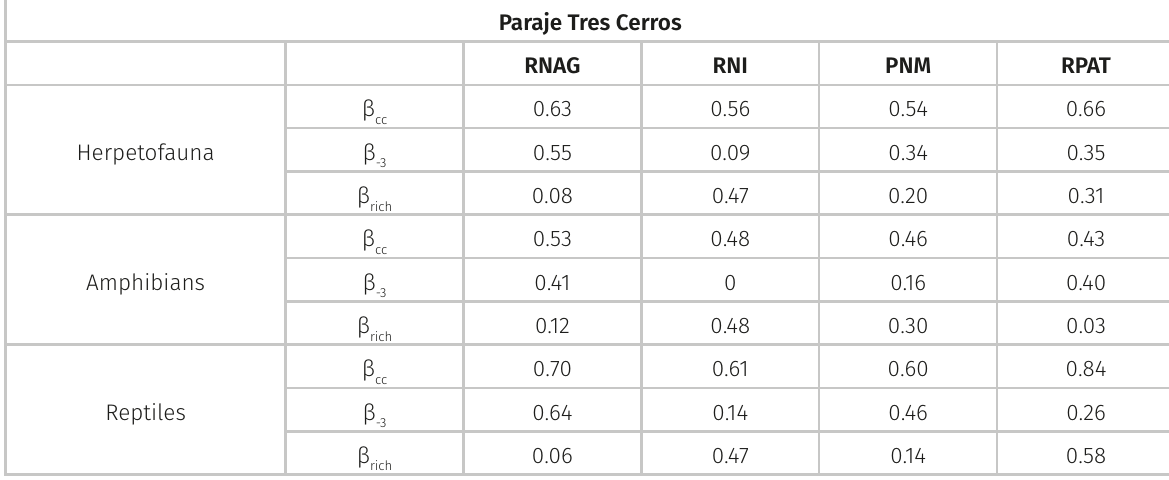
Table IV. Values of the overall beta diversity (β between rocky outcrops of Paraje Tres Cerros and natural areas from Corrientes province. RNAG: Reserva Natural Provincial Isla Apipe Grande, RPAT: Reserva Paleontológica del Arroyo Toropí, RNI: Reserva Natural del Iberá and PNM: Parque Nacional